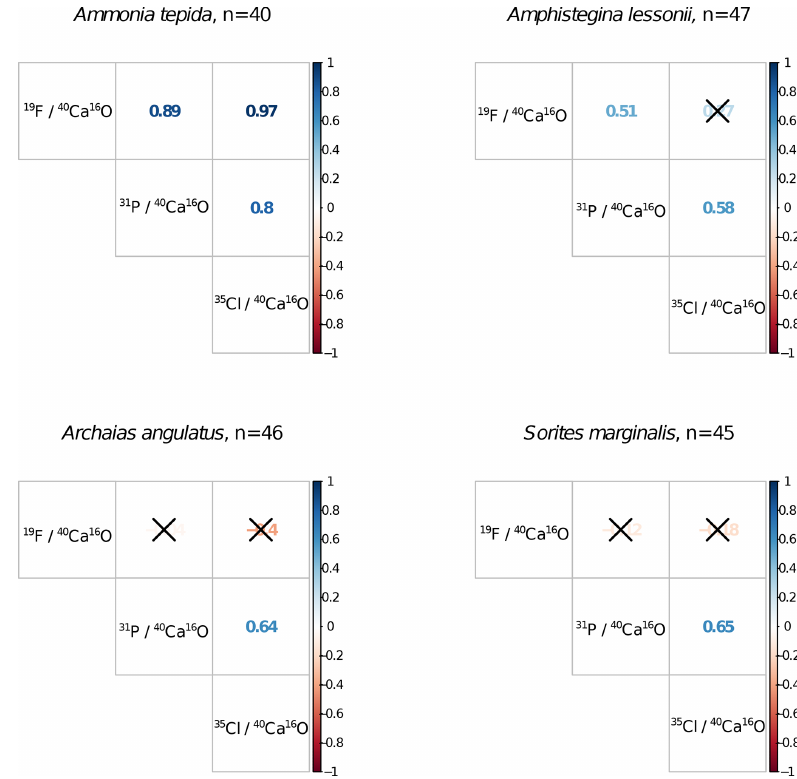
Figure A3. Correlation matrices of NanoSIMS 19 F / 40 Ca 16 O, 31 P / 40 Ca 16 O, and 35 Cl / 40 Ca 16 O ion count ratios per foraminiferal species across n ROIs. Coloured numbers in the matrix are the R 2 values, and the correlation is significant at the p < 0 . 001 level when no black cross is present. The plot was created using the corrplot package in R (Wei and Simko, 2017; R Core Team,